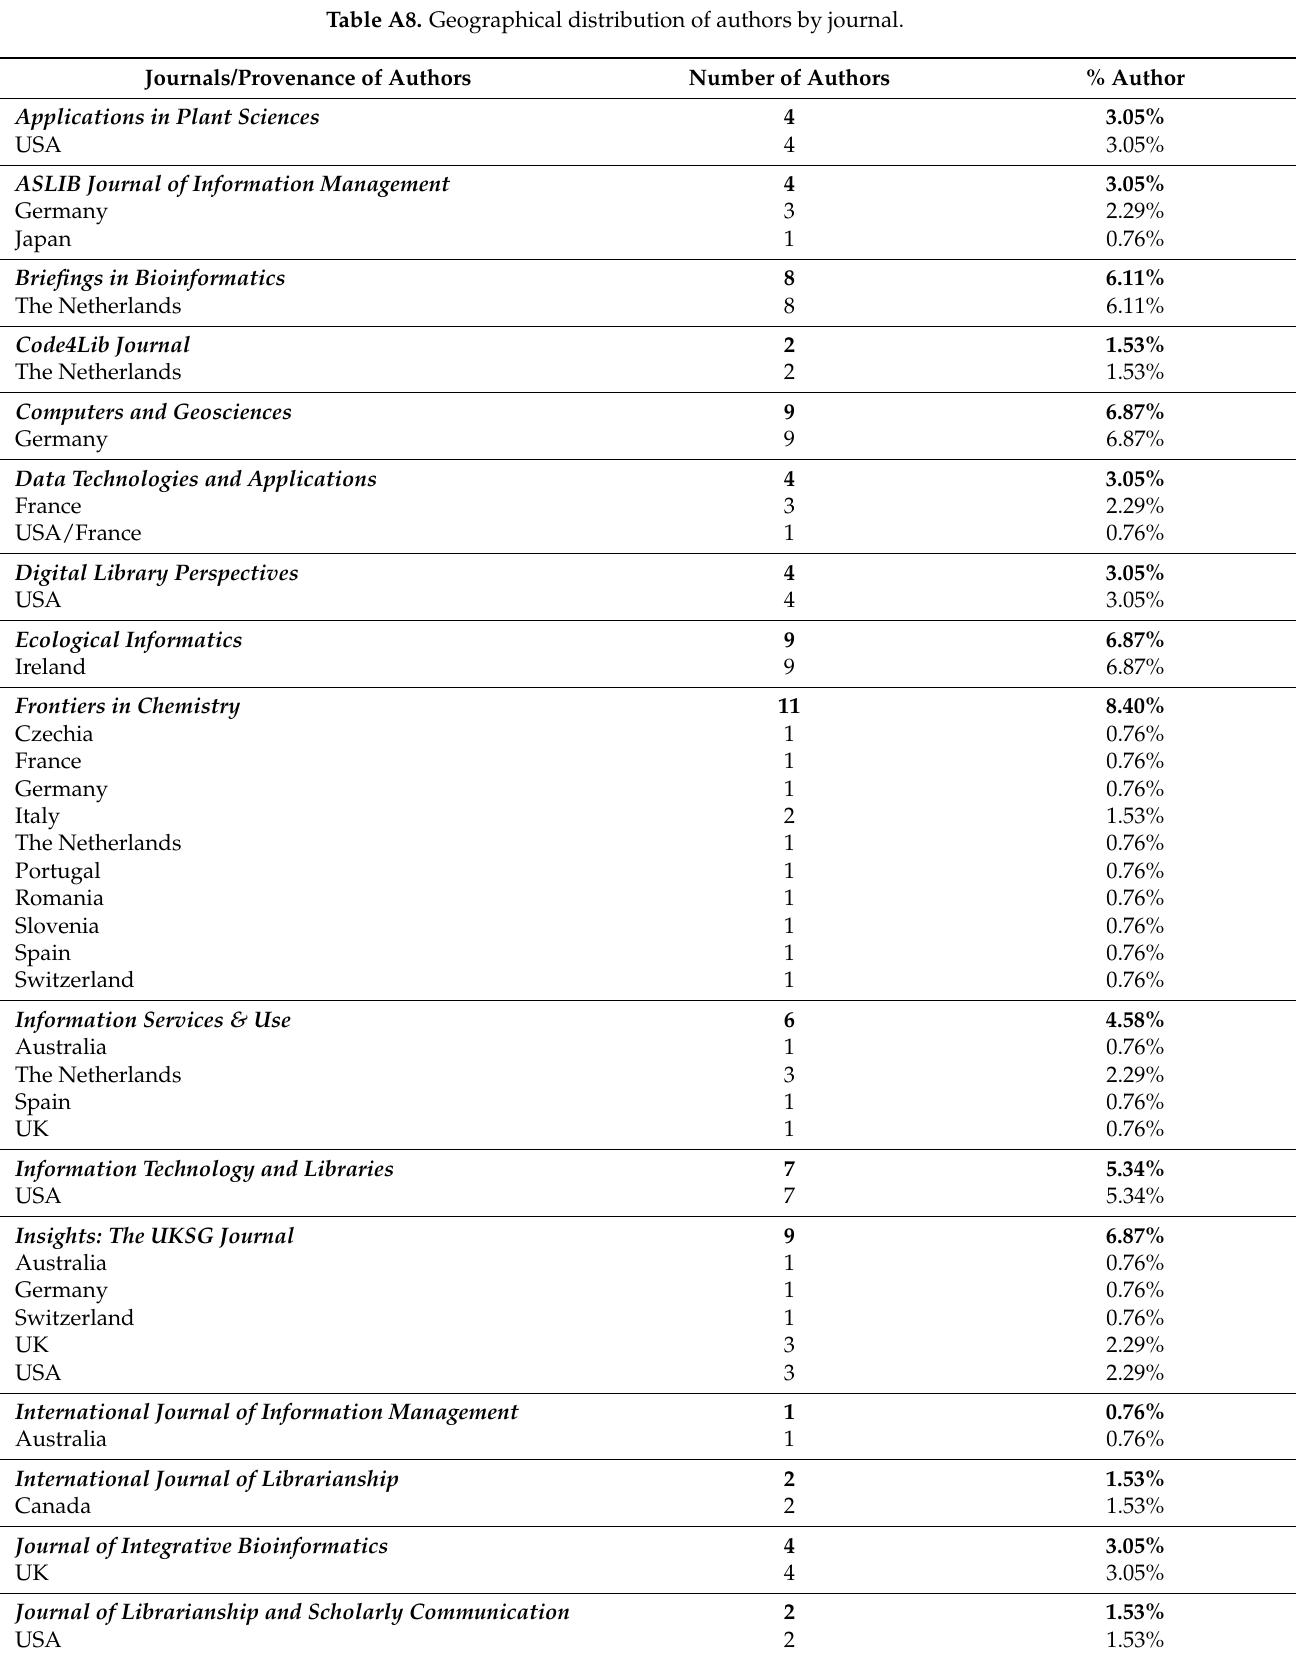
Table A8. Geographical distribution of authors by